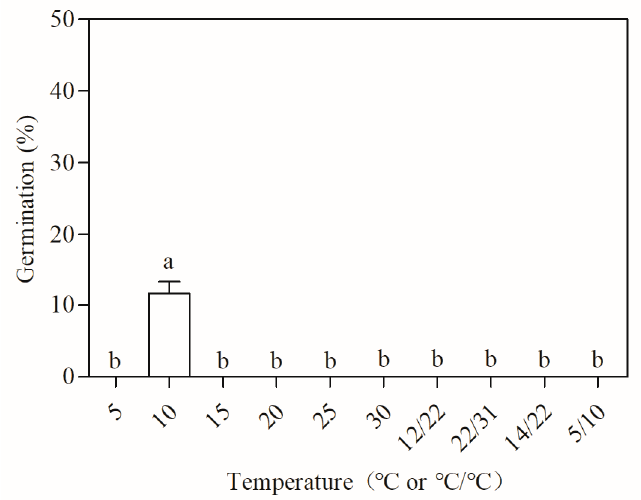
Figure 1. Germination of the freshly harvested seeds. Germination was performed at constant temperatures (5, 10, 15, 20, 25, and 30 ◦ C) or alternating temperatures (12/22, 22/31, 14/22, and 5/10 ◦ C) with a 12 h light/12 h dark cycle and PPFD = 121 µ mol · m − 1 · s − 1 . Each treatment had four replicates and 30 seeds were used for each replicate. There is no significant difference between the data labeled with the same lower case letters ( p = 0.05).